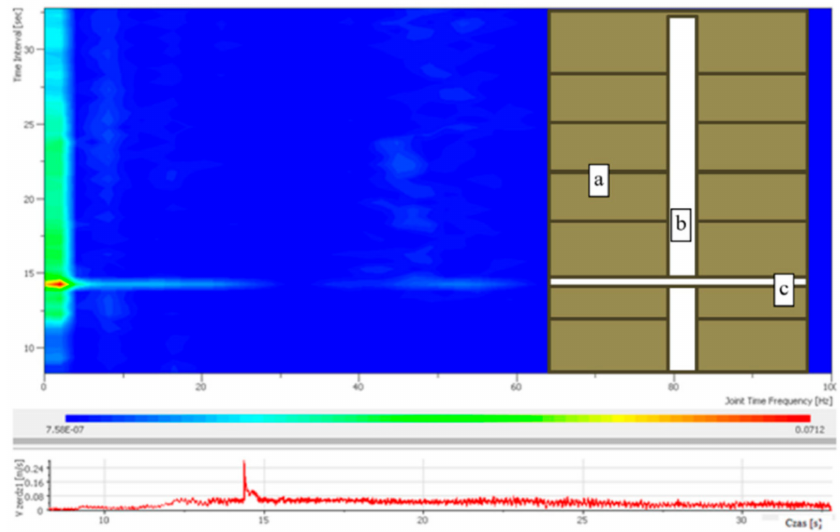
Figure 16. The detected signal on the recorded spectrogram corresponding to the location the critical discontinuity for borehole 1, rod 1—Hanning window; a, rock layer; b, borehole; c, discontinuity.